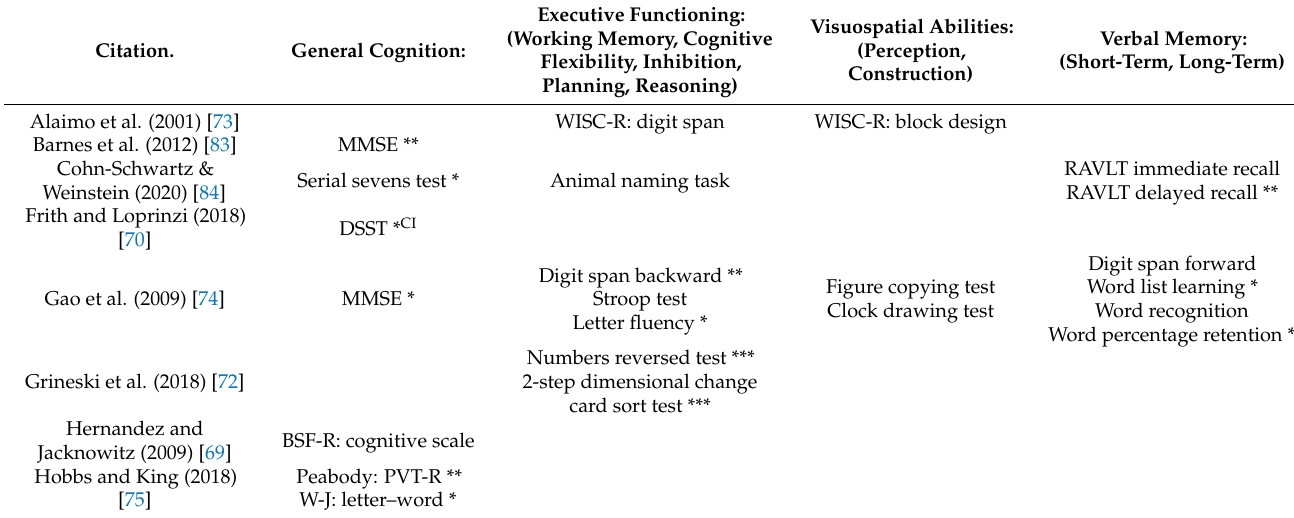
Table 2. Measures used across the life course by cognitive domain in studies exploring the mechanisms of food insecurity 1,2 .